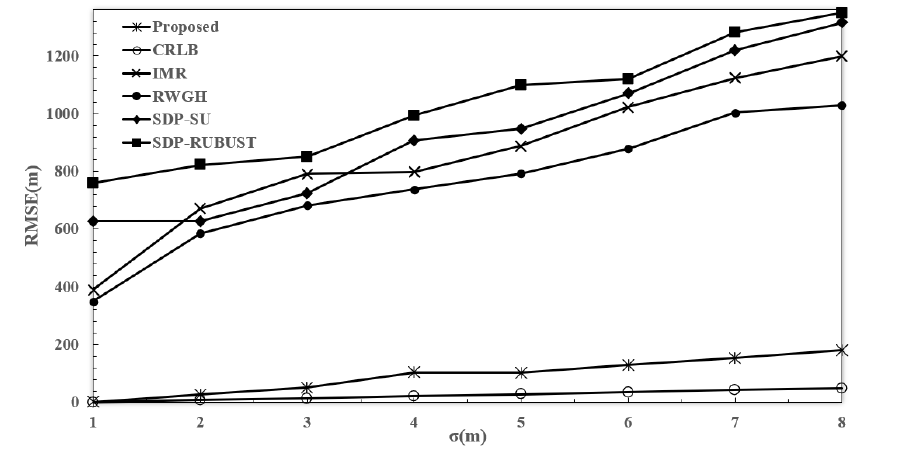
Figure 10. RMSE performance (Y-axis) across different standard deviations of the measurement error (X-axis: σ ) with one NLOS